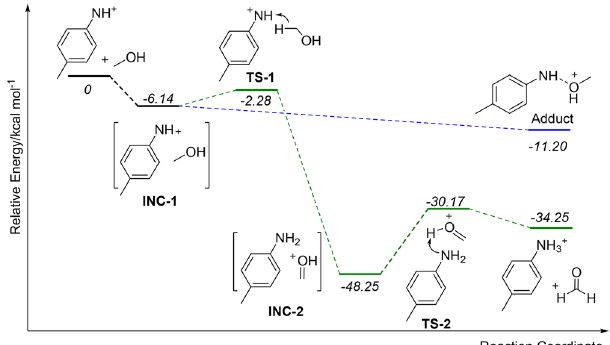
Figure 7. DFT potential energy diagram for the reaction mechanism of reaction 3 ; the numbers in italics are relative energies in kcal mol −1